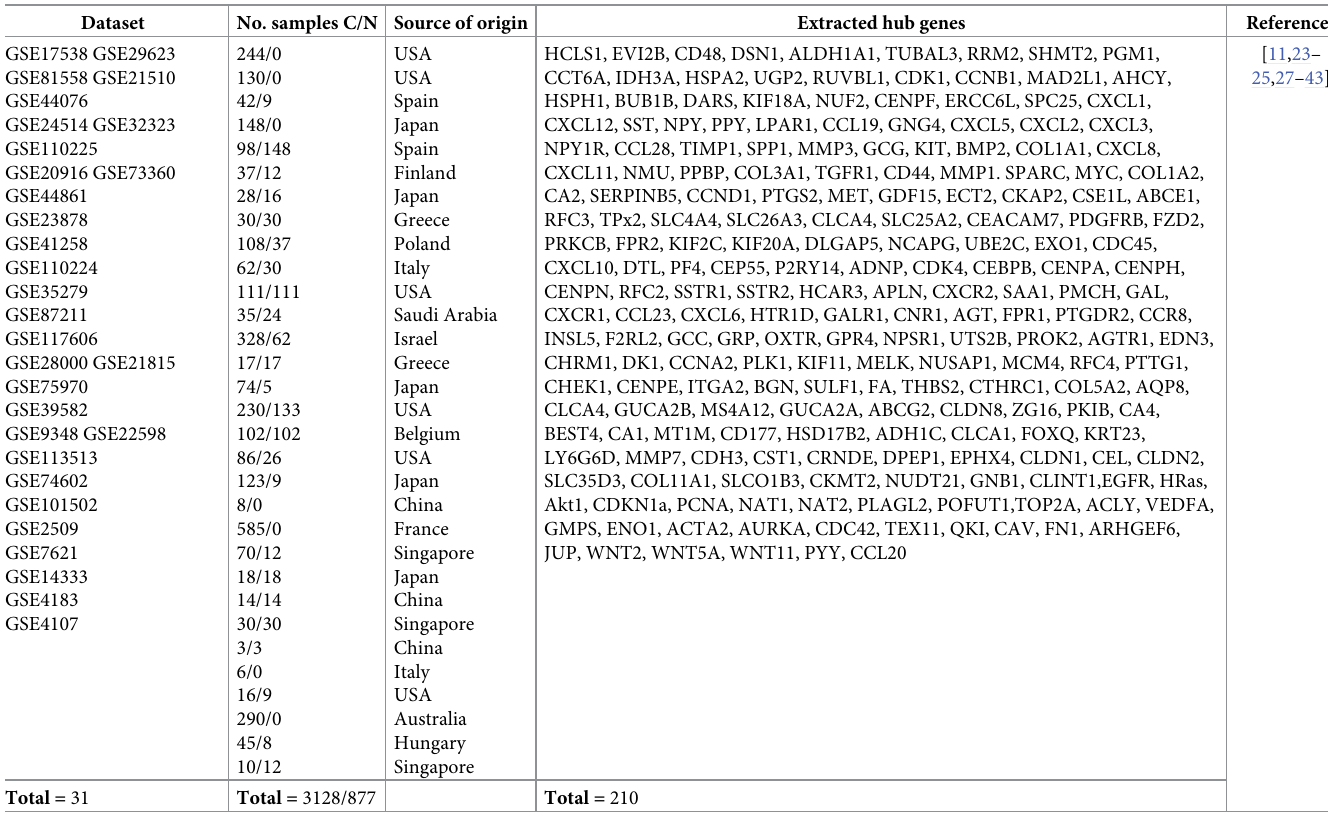
Table 1. Details of CRC microarray based expression datasets and the identified hub genes.